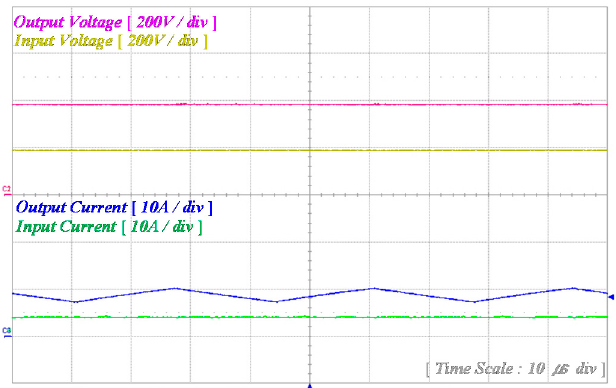
Figure 23. Waveforms of input / output voltage and current.